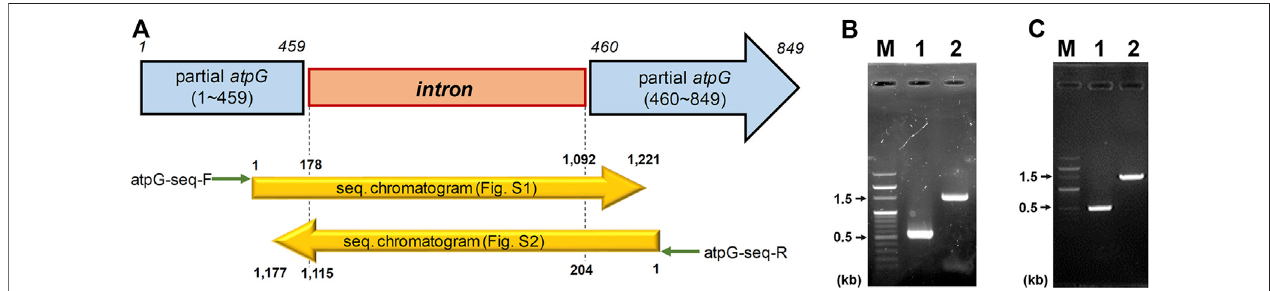
FIGURE 2 | Inactivation of C. acetobutylicum atpG gene by the intron insertion using mobile group II intron system. (A) Schematic diagram of the mutated atpG gene (blue) constructed by intron (orange) insertion. The intron was inserted between 459th and 460th nucleotides in the wild-type atpG gene, which was con fi rmed by sequencing using primers atpG-seq-F (green arrow) and atpG-seq-R (reverse green arrow; Supplementary Table S1 ). The mutated atpG gene was schematically aligned withDNA sequencing chromatograms (yellowarrows; see SupplementaryFiguresS1, S2 fordetailed chromatogram). (B,C) Validationofthe atpG gene mutation in strains 824-2866KD (B) and BEKW-2866KD (C) . The atp G-knockdown mutants, 824-2866KD and BEKW-2866KD were validated by PCR using primers atpG-F and atpG-R ( Supplementary Table S1 ). (B) M, 100-bp marker; lane #1, ATCC 824; lane #2, 824-2866KD. (C) M, 100-bp marker; lane #1, BEKW; lane #2, BEKW-2866KD.